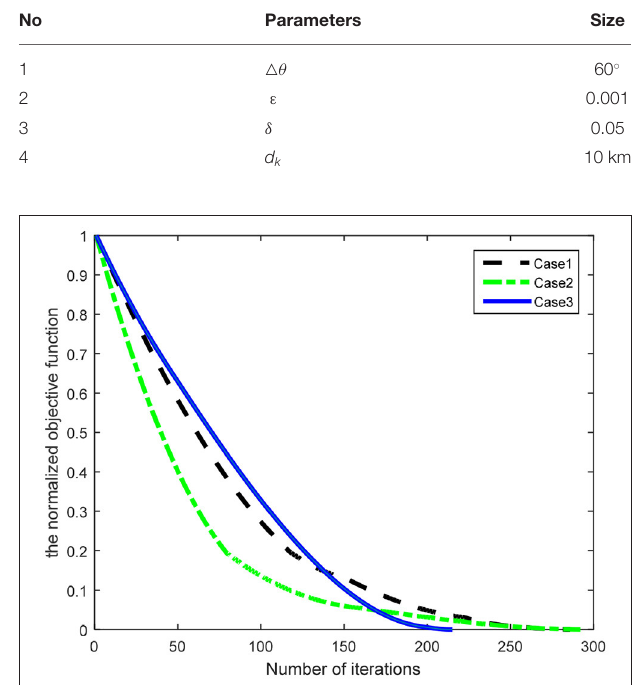
FIGURE 5 | Geomagnetic perceiving navigation within the Hex-path algorithm. FIGURE 6 | The convergence curves of the normalized objective